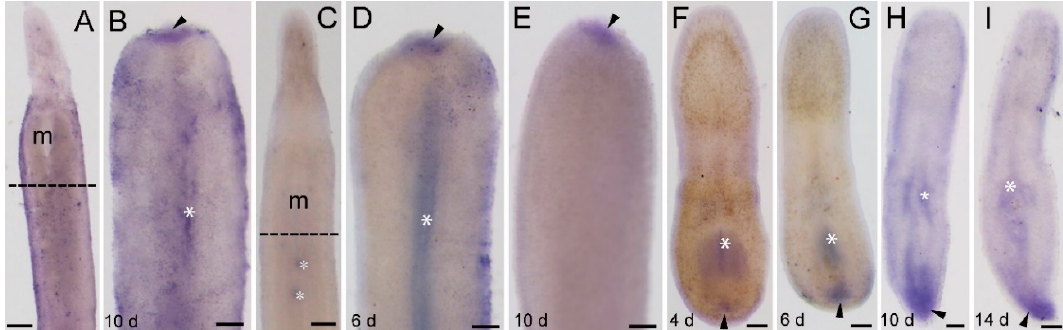
Figure 7. Expression of Ls-piwi2 and Ls-piwi3 during the regeneration of Lineus sanguineus . ( A ) Anterior region of an adult worm (control of Ls-piwi2 ); the dashed line indicates the site to perform amputation. ( B ) Ls-piwi2 expression during anterior regeneration (10 dpa; arrowed). ( C ) Anterior region of an adult worm (control of Ls-piwi3 ); the dashed line indicates the site to perform amputation. ( D , E ) Ls-piwi3 expression during anterior regeneration (6 and 10 dpa, respectively; arrowed). ( F – I ) Ls-piwi3 expression during posterior regeneration (4, 6, 10, and 14 dpa, respectively; arrowed). Expression domains are arrowed. Asterisks mark nonspecific staining (see Figure S4, Supplementary Materials). Scale bars: A,C = 250 μ m; B,D–I = 100 μ m.